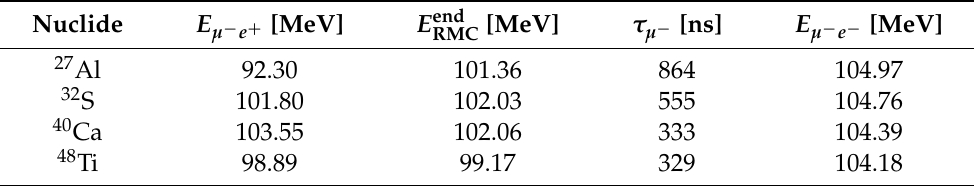
Table A2. The energy of the signal positron ( E µ − e + ) obtained from Equation(6), the RMC positron endpoint energy ( E end ) of the ground-state transition obtained from Equation (7), and the lifetime RMC of the muonic atom ( τ µ − ) of some nuclei considered for µ − → e + experiments. The energy of the signal electron ( E µ − e − ) for µ − → e − are also shown for comparison. Nuclear masses required for these calculations are taken from AME2016 data[68]. The lifetime data is from